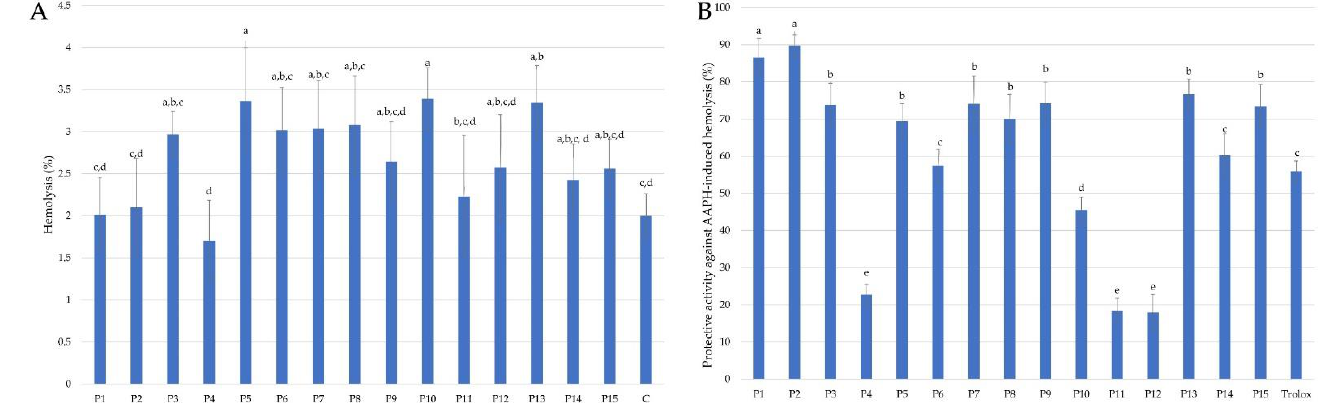
Figure 3. Hemolytic activity ( A ) and cytoprotective effects ( B ) of propolis extracts used at the concentration 0.05 mg/mL against 2,2 ’ -azobis(2-methylpropionamidine) dihydrochloride (AAPH)-induced oxidative hemolysis (means ± SD). (Values denoted with identical letters do not differ significantly).